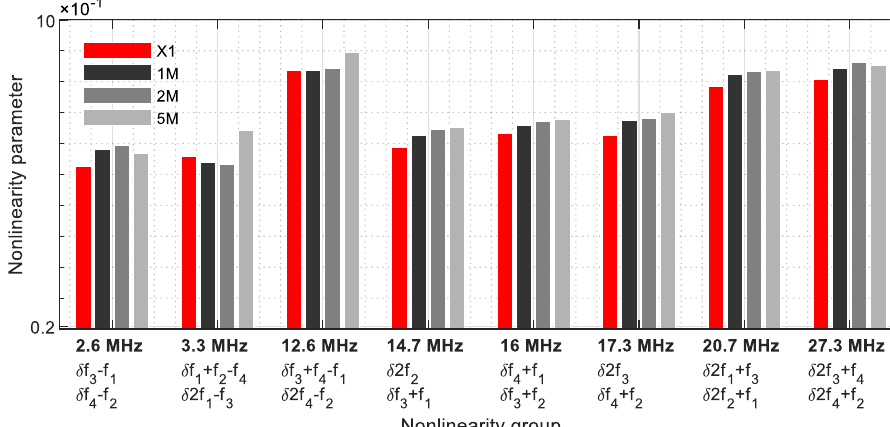
Figure 22. Nonlinearity parameter — δ G2 .